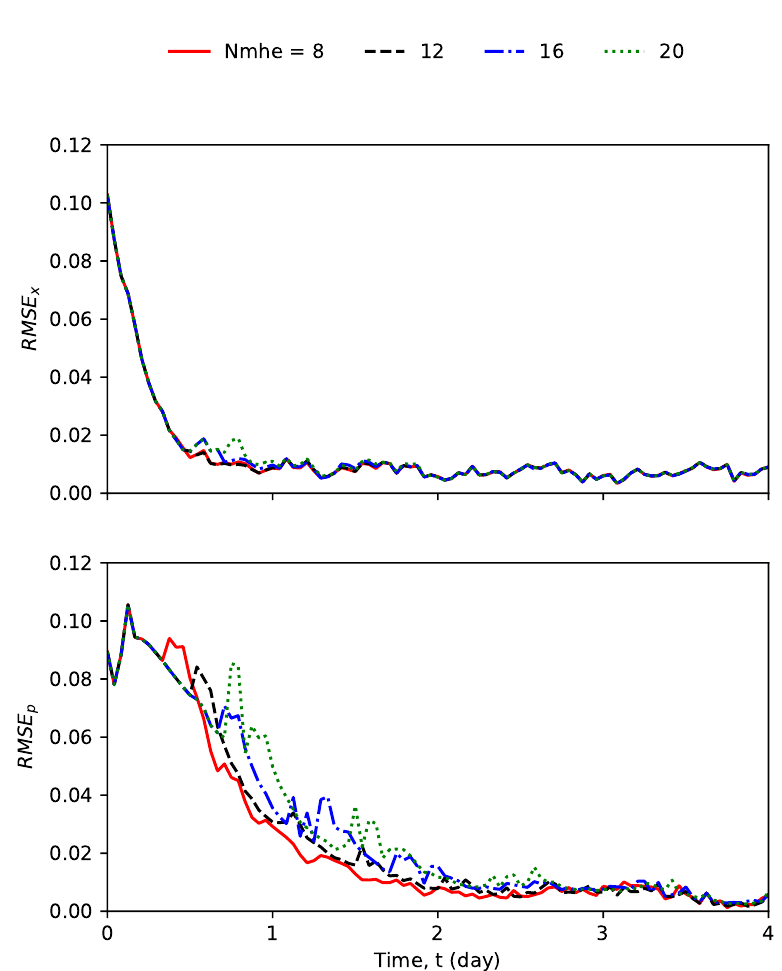
Figure 8. Trajectories of RMSE measuring actual model and estimated states and parameters of MHE with window sizes of 8, 12, 16 and